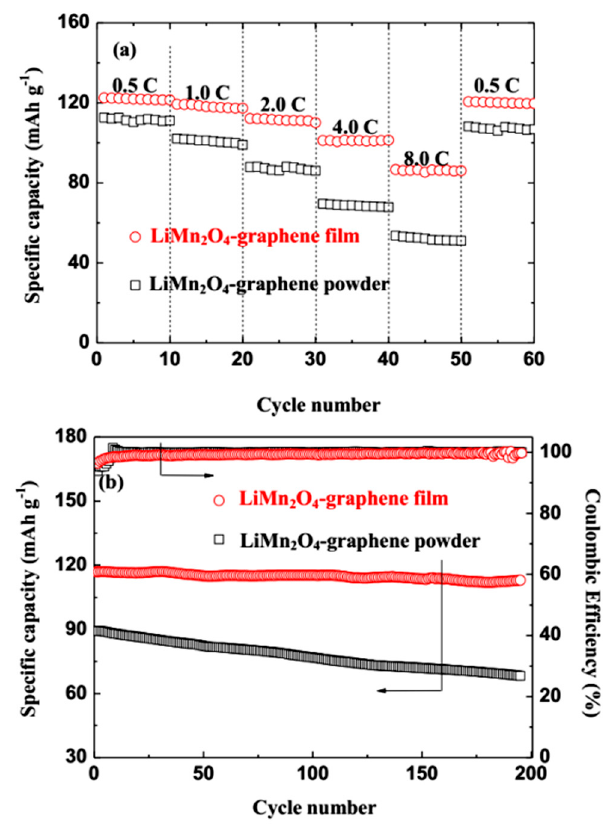
Figure 7. Rate capability ( a ) and cycle performance at 1C ( b ) of the LiMn 2 O 4 -graphene powder and LiMn 2 O 4 -graphene film cathodes.